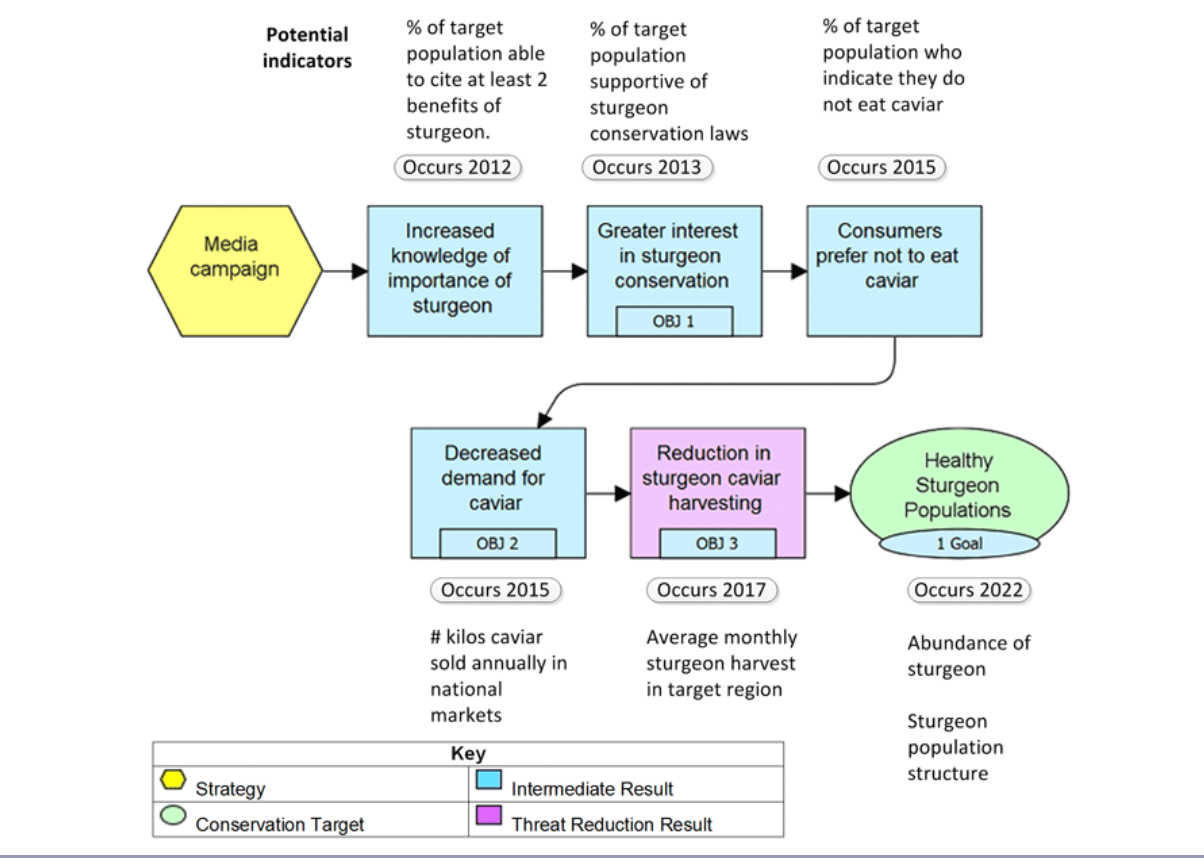
Fig. 6 . Relationship between results chains, indicators, and temporal sequence.